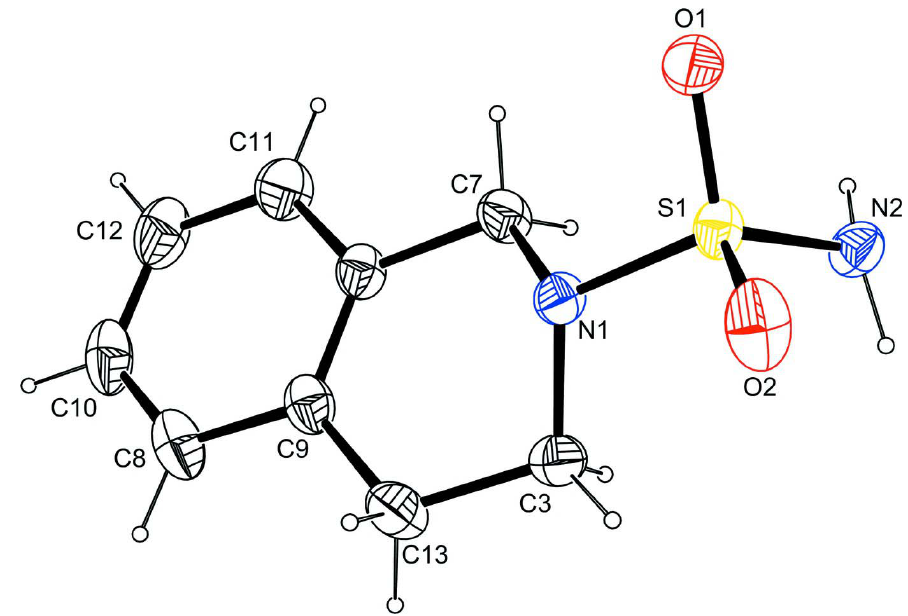
Figure 1 Molecular View of the title compound. Displacement ellipsoids are drawn at the 30% probability level. H atoms are represented as small spheres of arbitrary